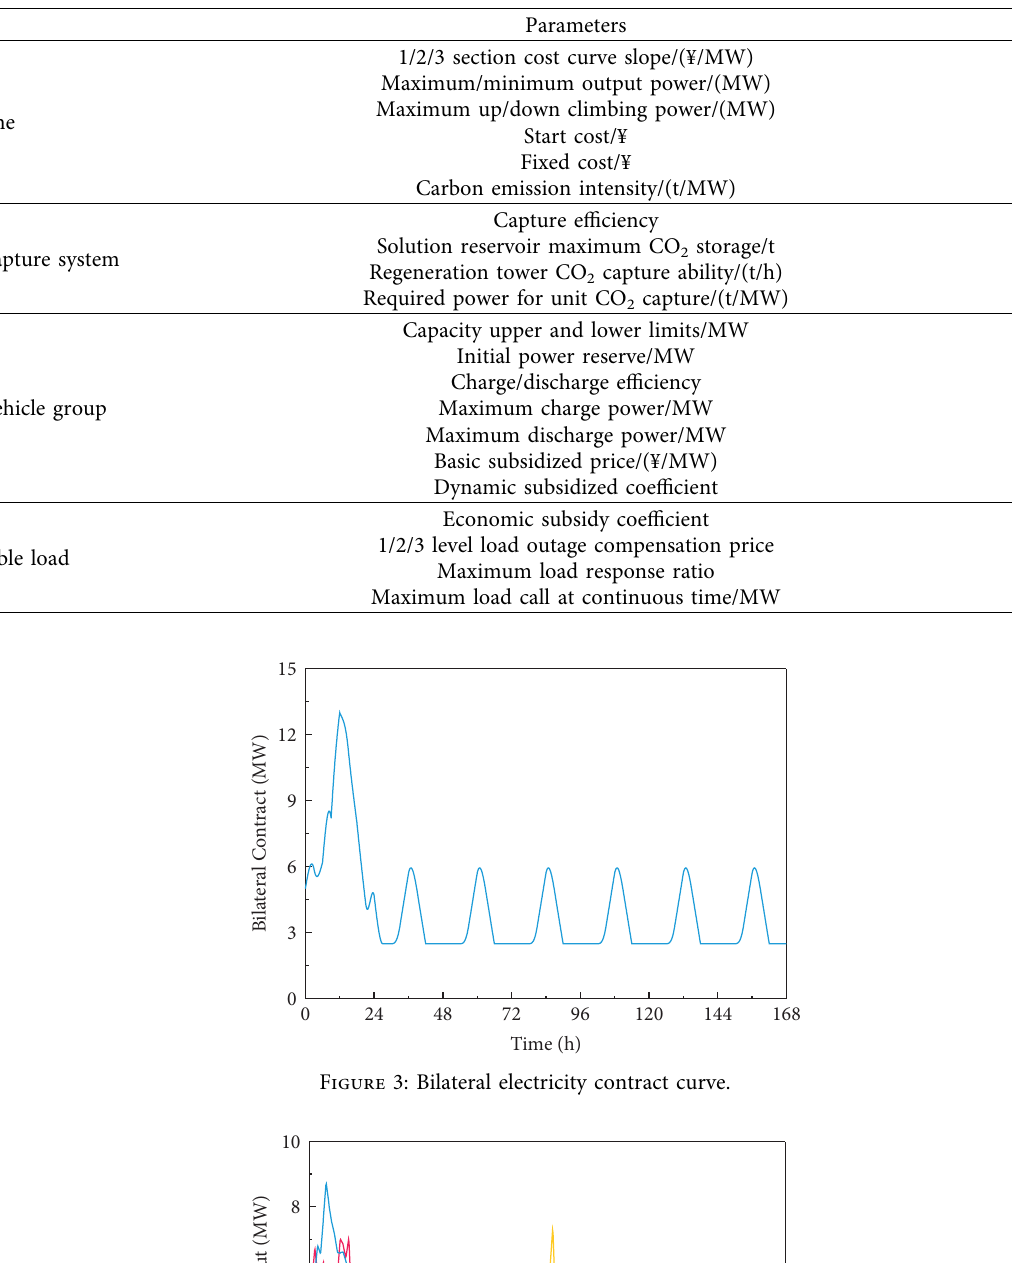
Table 1: Parameters of aggregated units in VPP.